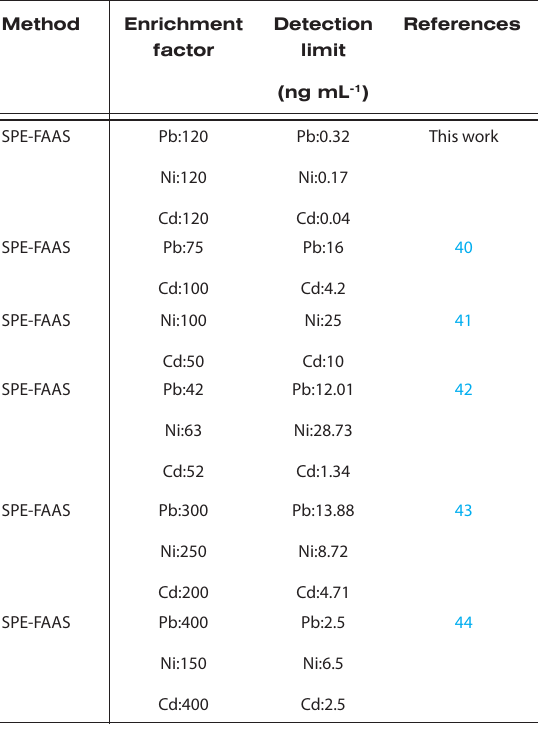
Table 5. Comparison the detection limits of proposed methods with other methods. Method